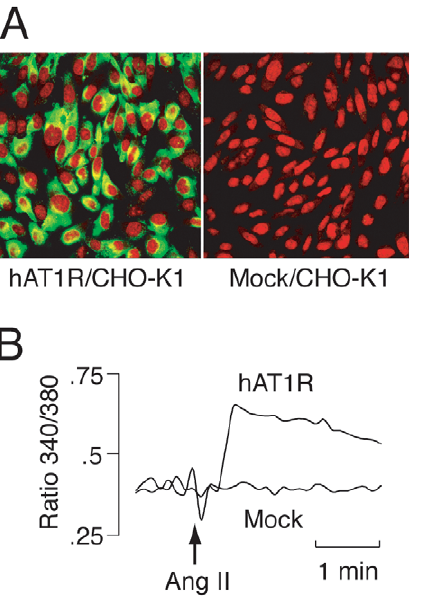
Figure 2. Stable expression of a model GPCR, the recombinant human angiotensin II type 1 receptor (hAT1R) with the C- terminal c-myc tag, on CHO-K1 cells. ( A ) Immunofluorescence staining of hAT1R-c-myc-expressing CHO-K1 cells (hAT1R/CHO-K1, left ) and CHO-K1 cells transfected with the empty vector alone (Mock/CHO- K1, right ) with anti-c-myc antibody (green). Nuclei were stained with PI (red). ( B ) Confirmation of the function of hAT1R-c-myc by monitoring changes in intracellular Ca 2 + in response to angiotensin II (Ang II). Fura- 2/AM-loaded hAT1R/CHO-K1 or Mock/CHO-K1 cells were exposed to 1 nM Ang II at the point indicated by the arrow. The results are expressed as Fura-2 fluorescence ratio (340/380 nm).